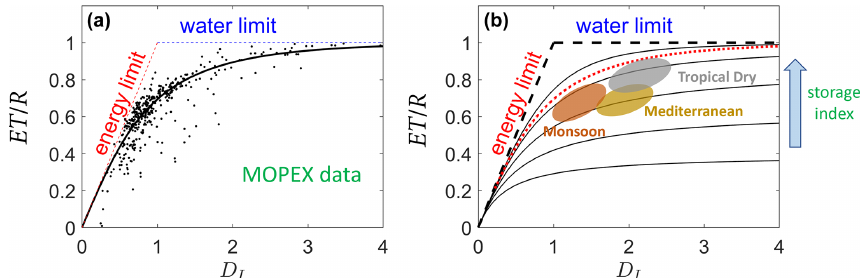
Figure 2. Rainfall partitioning. (a) Test of Budyko’s hypothesis using the MOPEX data (Porporato and Yin, 2022). The solid line shows the ( 1 − e − D I )) 1 / 2 . (b) Different solutions of the mean partitioning of the original semi-empirical curve used by Budyko, (cid:53) B = (D I tanh D − 1 I minimalist soil moisture balance model of Porporato et al. (2004), showing the role of the storage index, γ = w 0 /α , and seasonality (Feng et al., 2012). The red dotted line is the original curve of